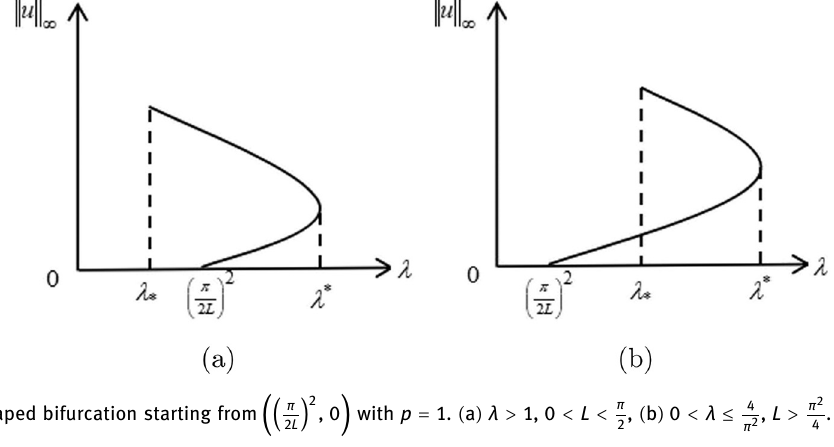
Figure 2: ⊃ - shaped bifurcation starting from